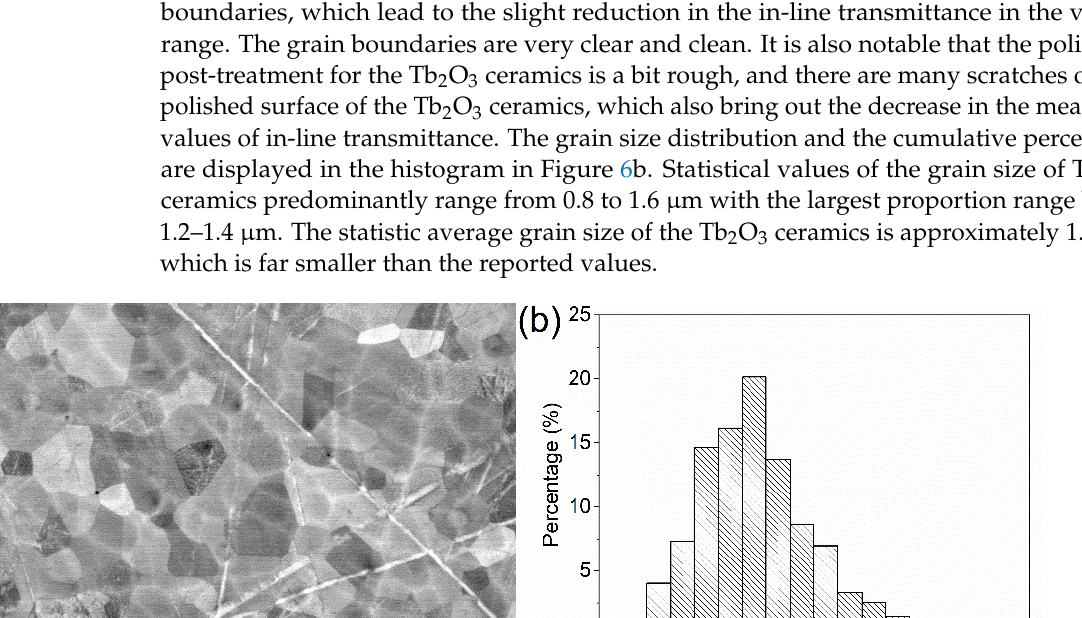
Figure 5. Photograph and in-line transmission curve of the synthetic Tb 2 O 3 ceramics (thickness = 1.0 mm).